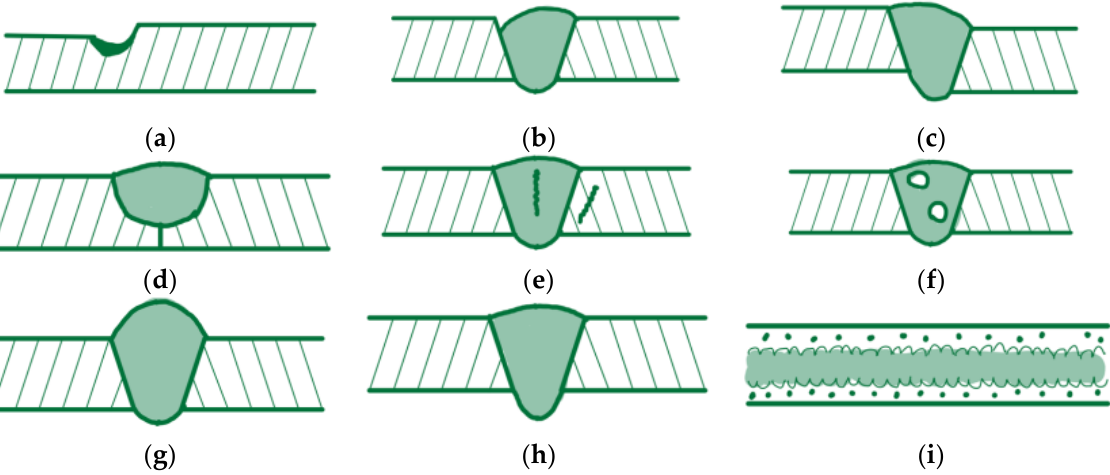
Figure 1. Laser micro-welding most common defects adapted from [38]: ( a ) End crater; ( b ) Underfill; ( c ) Misalignment; ( d ) Lack of penetration; ( e ) Cracks; ( f ) Porosity; ( g ) Excessive reinforcement; ( h ) Excessive penetration; ( i )